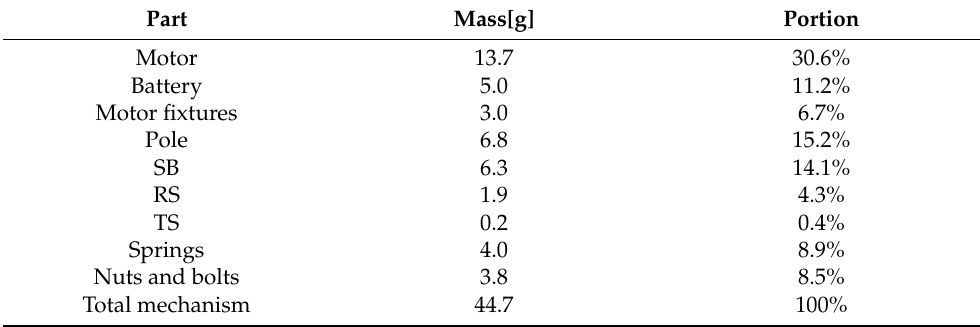
Table 2. Weight budget of proposed jumping mechanism.